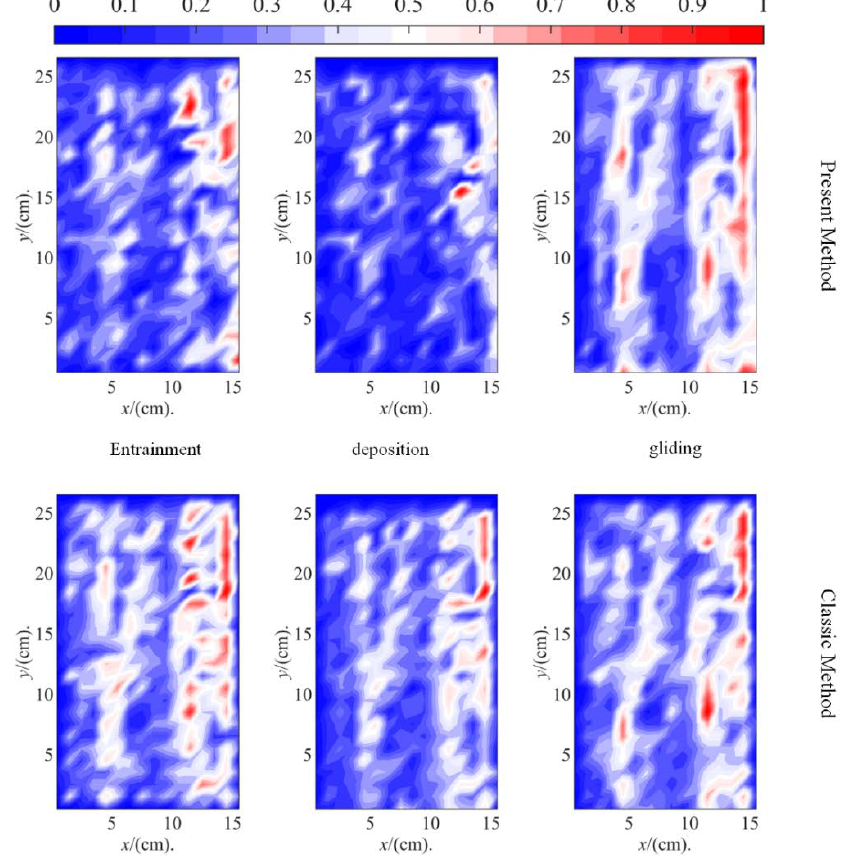
Figure 14. Spatial distribution of entrained, deposited and gliding particles from left to right in every row, respectively. The figures in top and bottom row are the results calculated by present method and classic method. The flow direction is from bottom to top.